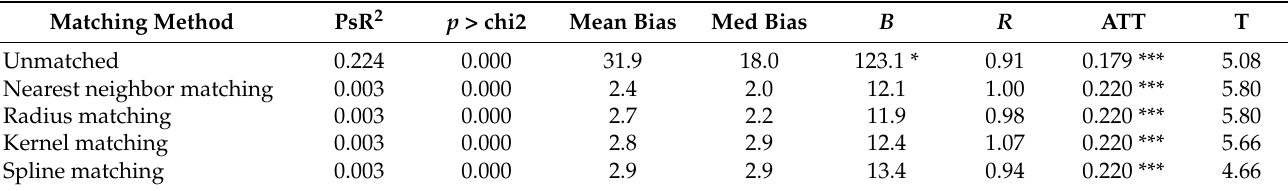
Table 3. Balance test and average treatment effect of matched